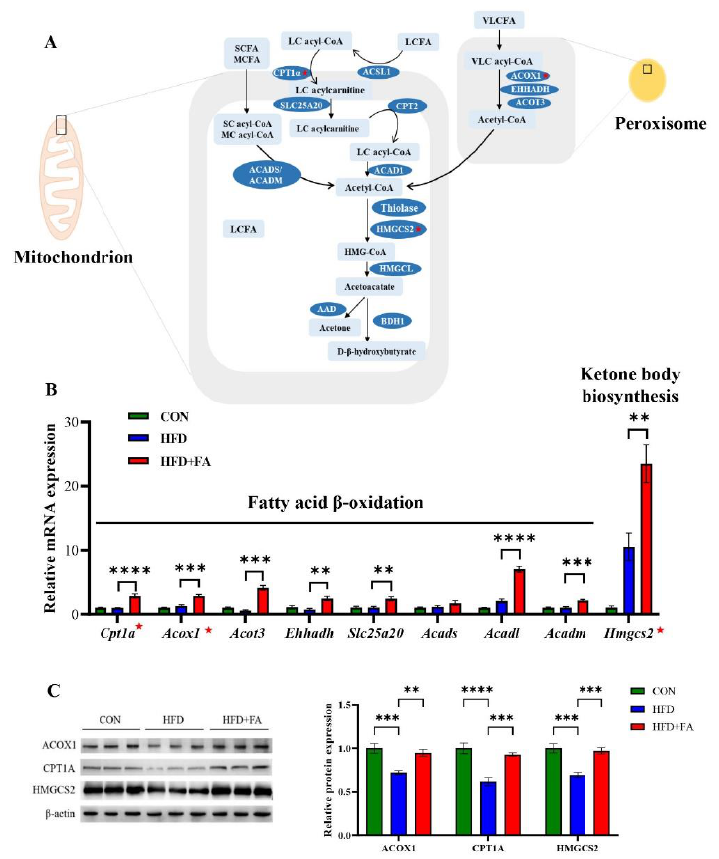
Figure 4. FA increased fatty acid oxidation and ketone body biosynthesis in liver. ( A ) Schematic representation of fatty acid oxidation and ketone body biosynthesis pathways. ★ : the rate-limiting enzyme. ( B ) The relative mRNA levels of genes involved in fatty acid oxidation and ketone body biosynthesis in the livers of the CON, HFD and HFD+FA mice ( n = 6). ( C ) The relative protein levels of CPT1 α , ACOX1, and HMGCS2 ( n = 3). Data are shown as mean ± SEM. ** p < 0.01, *** p < 0.001, **** p < 0.0001.